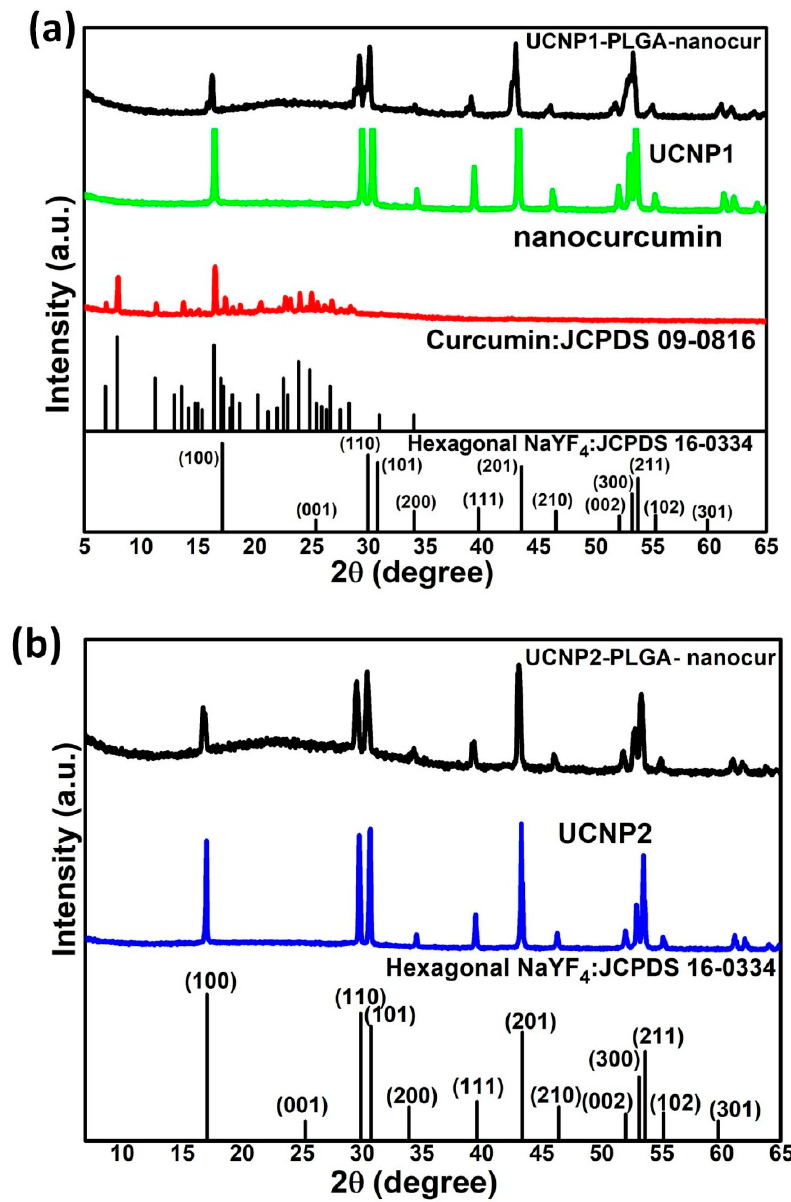
Figure 3. XRD patterns of ( a ) NaYF 4 :Yb,Er (UCNP1), nanocurcumin, UCNP1-PLGA-nanocur ( b ) NaYF 4 :Yb,Tm (UCNP2), and UCNP2-PLGA-nanocur. Table 1. The lattice parameters of UCNP and the UCNP-PLGA-nanocurcumin complexes.